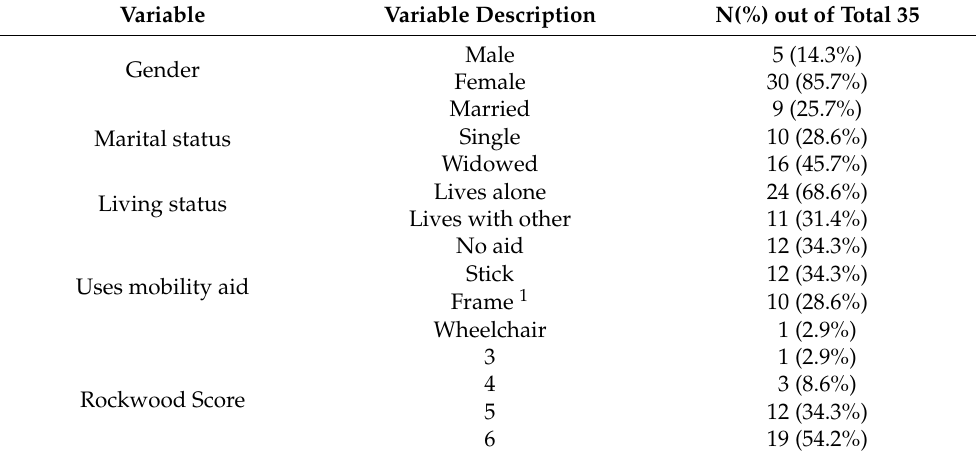
Table 1. Participant characteristics at